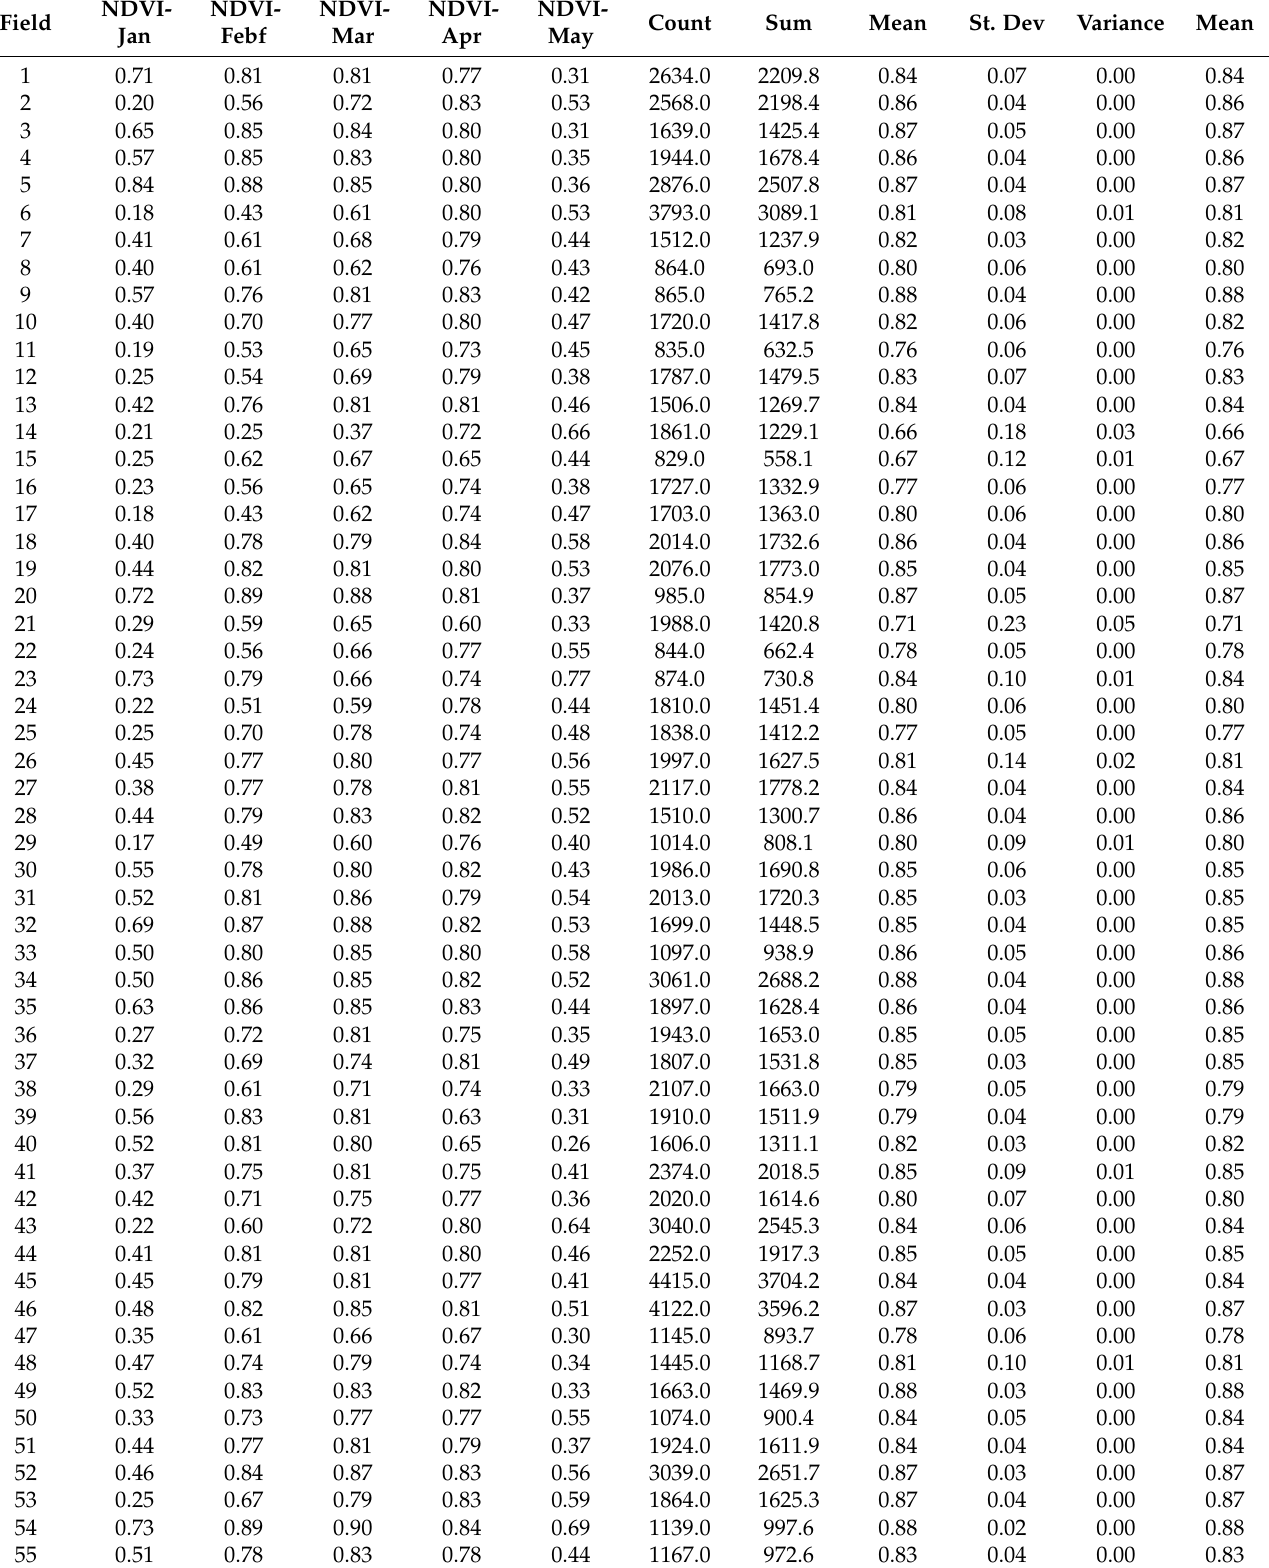
Table A2. Monthly Average NDVI in 143 Center Pivot Values Zonal